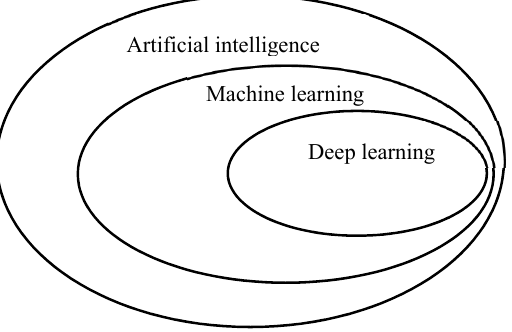
Figure 1. A Venn-diagram of artificial intelligence: link between artificial intelligence, machine learning and deep learning.